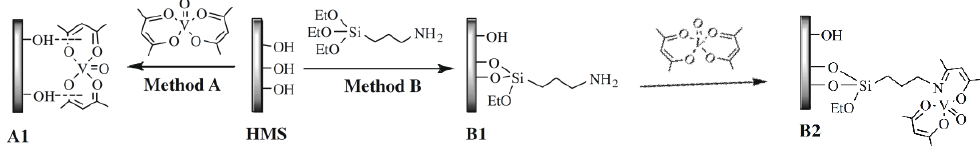
Figure 12. Methodologies for [VO(acac) 2 ] immobilization onto HMS materials. Adapted with permission from Reference. [134] Copyright (2009) Elsevier B.